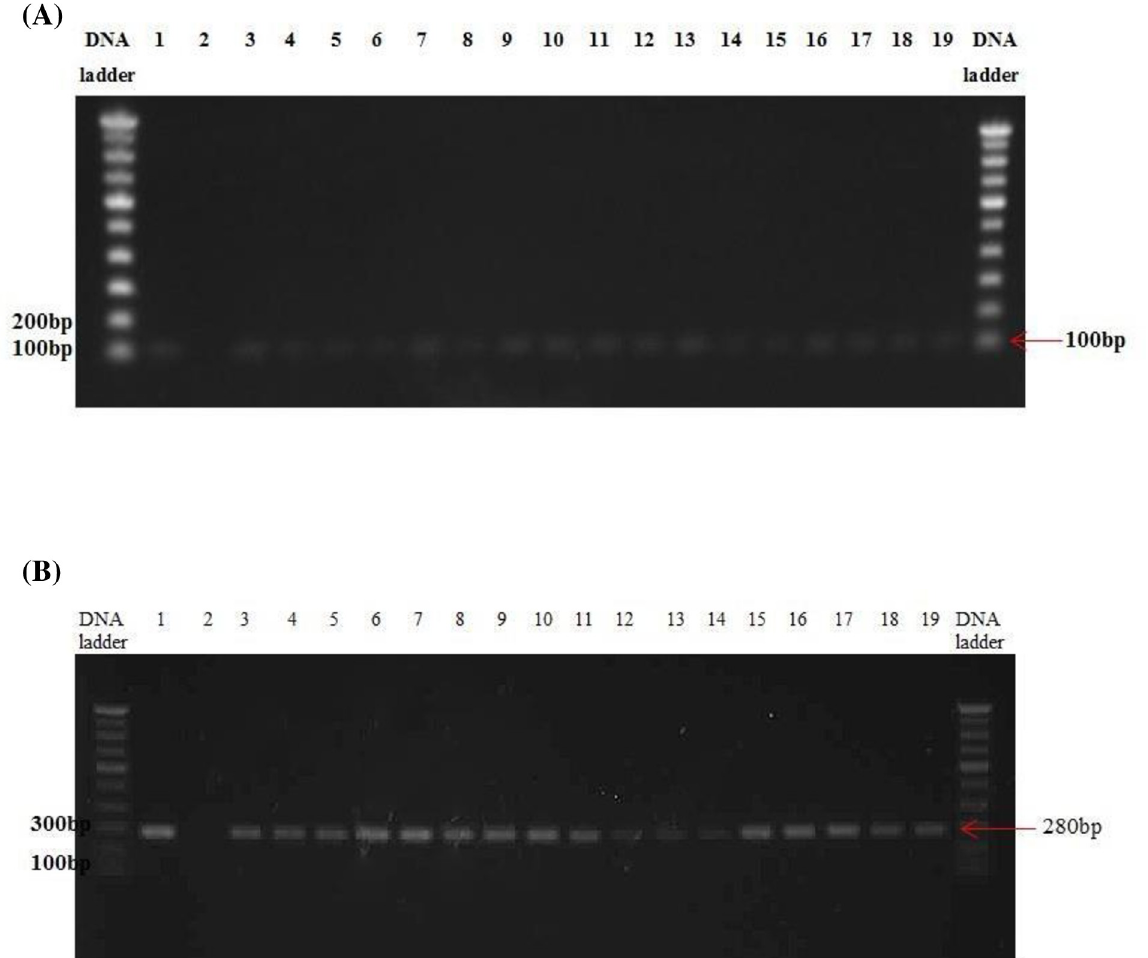
Fig 2. PCR amplification; (A) 16 s rRNA (100 bp) and (B) colibactin (clbB) genes (280 bp) of CRC patients and healthy controls was visualized on 1% agarose gel. Lane 1 shows positive control (+) while lane 2 shows negative control (-), followed by lanes 3–18 showing positive bands from CRC patients and lane 19 shows positive band for healthy